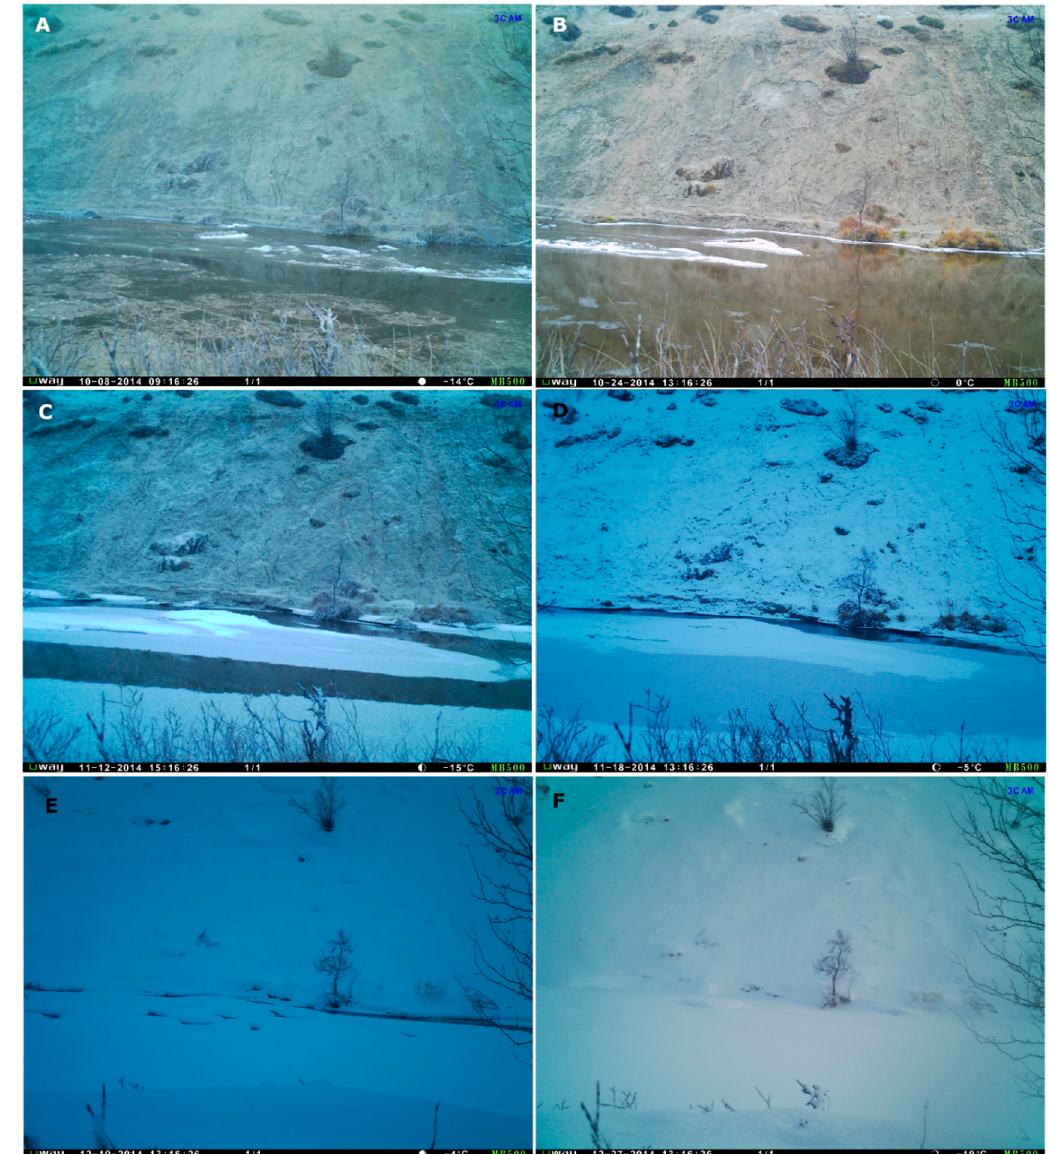
Figure 5. The ice cover development during 2015 autumn. ( A ) Ice appears for the first time on 8 December 2015 ( − 15 Celsius degrees). The (frazil) ice is floating as rafts. ( B ) The ice starts piling on top of the mid-channel bar (24 December 2015). ( C ) This 8 November 2015 time step is the first time when the border ice has started to grow around the mid-channel. Before this, there had been four times frazil ice, ice piling on top of the mid-bar and melting. After the fourth appearance (5 November 2015), the ice did not anymore melt totally. ( D ) The thin ice is covering most of the channel on 18 November 2015. Only an open strip exists next to the outer bank. ( E ) There is more ice and snow on 10 December 2015. Some openings appear in the middle of the channel and next to the bank. ( F ) The river got full ice cover on 14 December 2015, but wet areas appeared around 20–25 December 2015. After 27 December 2015, there is permanent full ice cover, which lasts more or less until the melting.